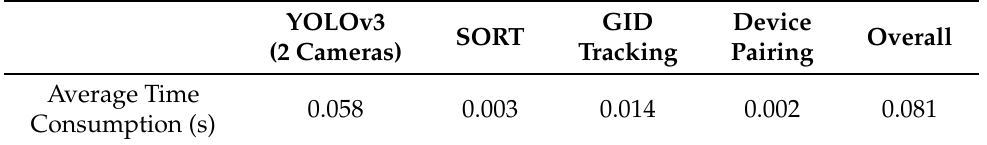
Table 1. Processing time of major